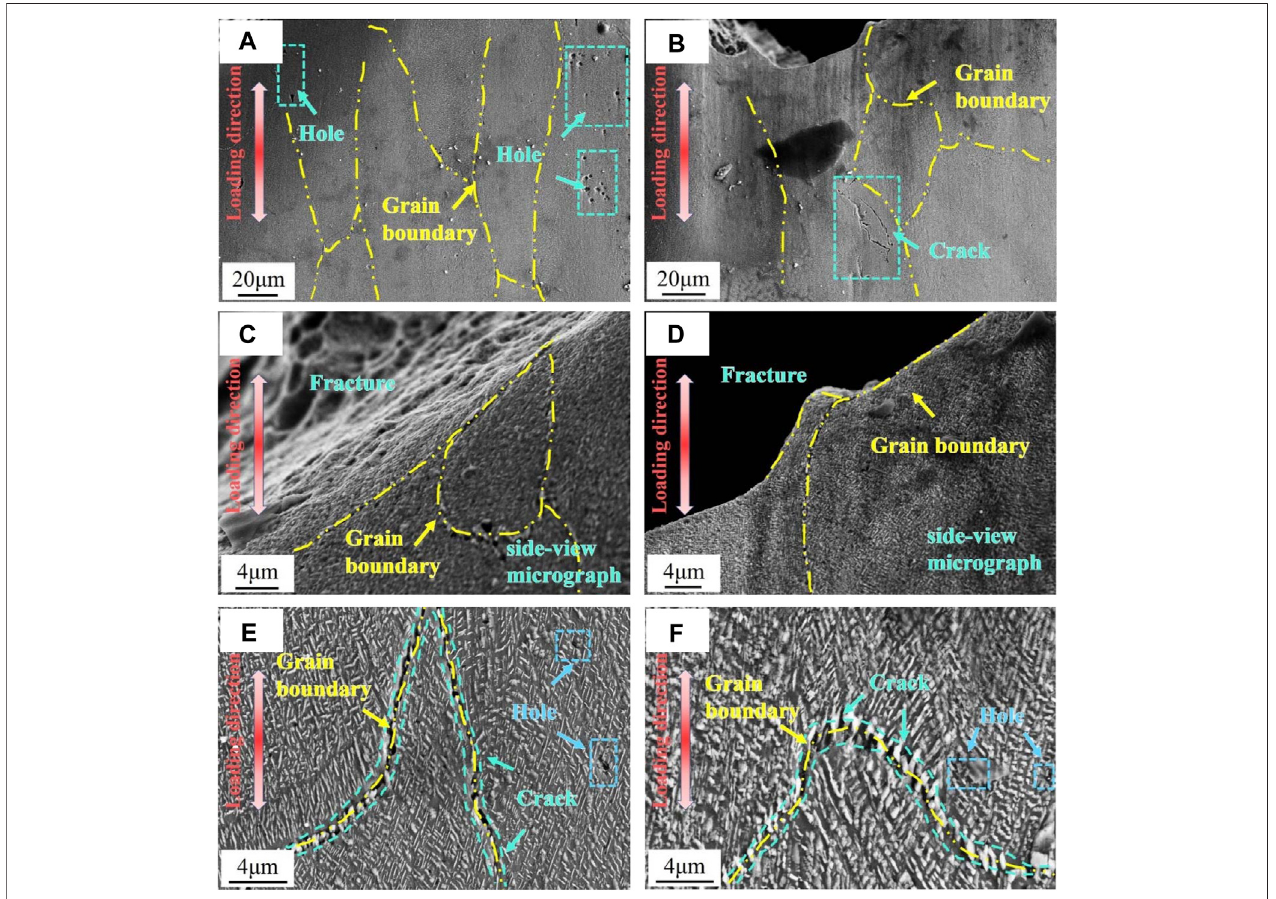
FIGURE 11 | The side-view micrographs of superalloy tensile test samples after aging at 1073 K for 512 h: (A,C,E) 2Cr and (B,D,F) 2Mo.